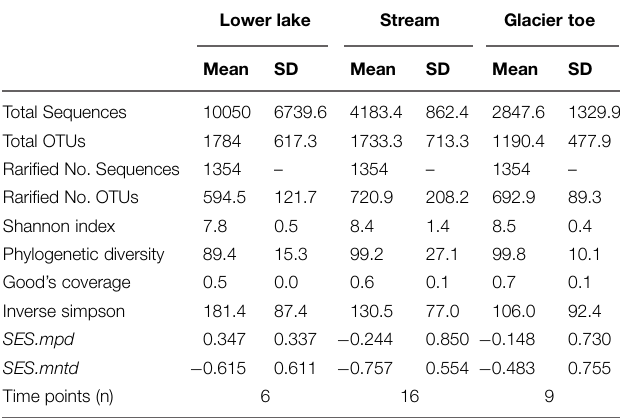
TABLE 1 | Summary of sequencing results and alpha diversity for each of the three sampling